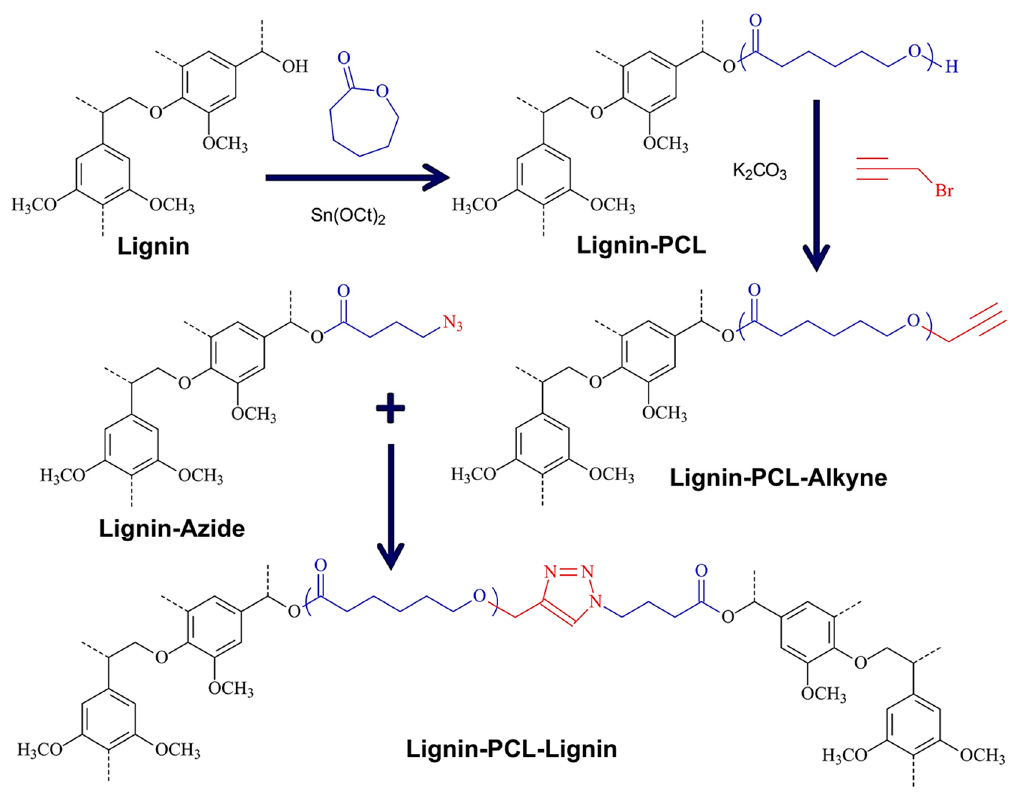
Figure 31. Synthesis of lignin copolymers via copper-free thermal click chemistry of Lignin-PCL-Alkyne with Lignin-Azide functional macromolecules. Reproduced with permission [104].